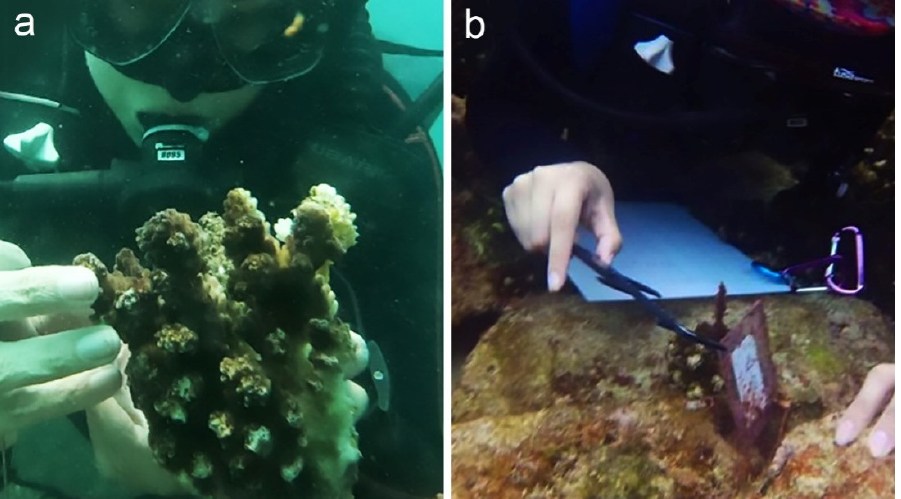
Figure 2. Coral fragment transplantation and monitoring. ( a ) Coral fragment selection; ( b ) Fixing and labeling of Pocillopora fragments without Trapezia .